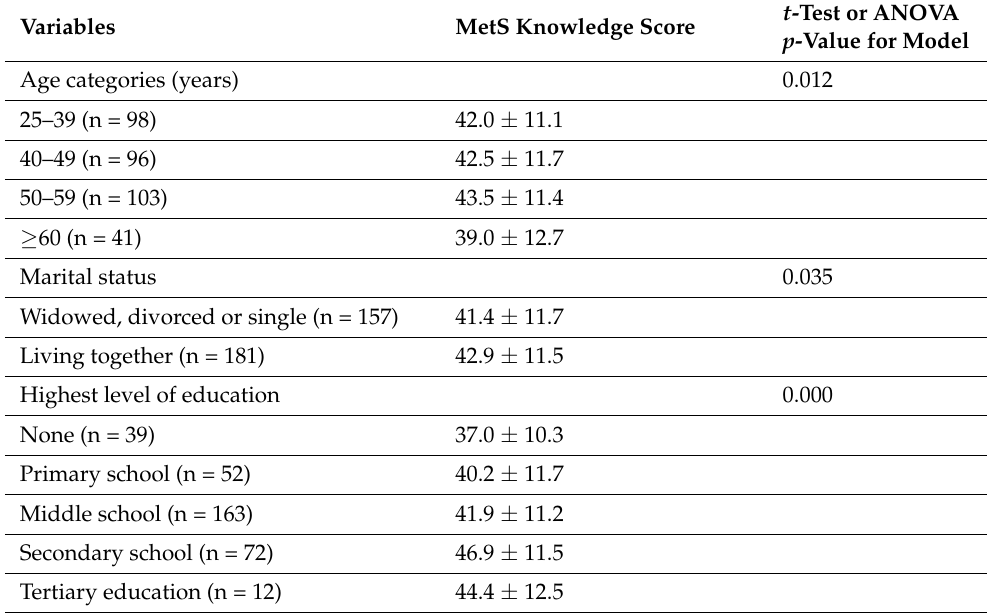
Table 1. Demographic, anthropometric, cardiometabolic characteristics and knowledge of MetS.